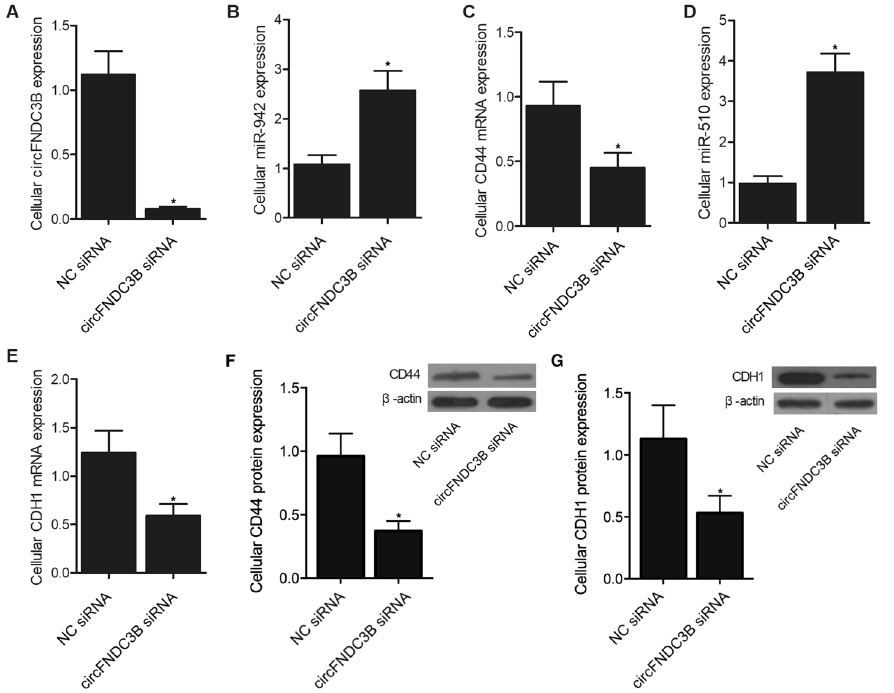
Figure 3. Validation of signaling pathway establishment (* P value < 0.05 vs. NC siRNA group). ( A ) CircFNDC3B expression was inhibited by the knockdown of circFNDC3B in MKN28 cells; ( B ) MiR-942 expression was up-regulated by the knockdown of circFNDC3B in MKN28 cells; ( C ) CD44 mRNA expression was suppressed by the knockdown of circFNDC3B in MKN28 cells; ( D ) MiR-510 expression was increased by the knockdown of circFNDC3B in MKN28 cells; ( E ) CDH1 mRNA expression was down-regulated by the knockdown of circFNDC3B in MKN28 cells; ( F ) CD44 protein expression was suppressed by the knockdown of circFNDC3B in MKN28 cells; ( G ) CDH1 protein expression was down-regulated by the knockdown of circFNDC3B in MKN28 cells.